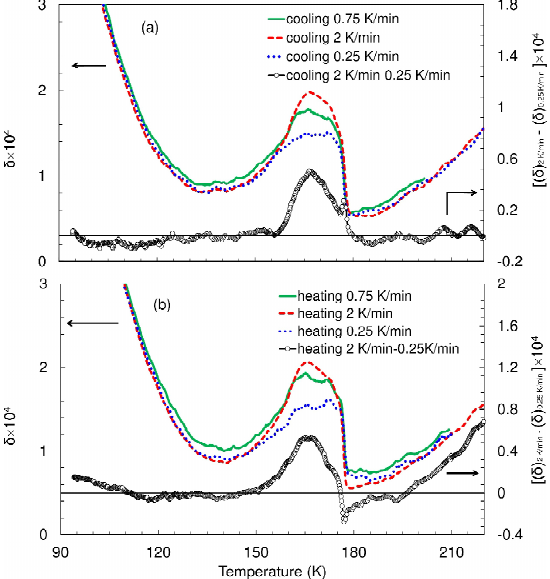
Fig. 2. Internal friction,  , in thermocycles 250K – 95K – 250K performed under cooling-heating rates of 2 K/min, 0.75 K/min, and 0.25 K/min: (a) cooling (b) heating; difference between spectra at 2 K/min and 0.25 K/min is shown as well. Oscillatory strain amplitude  = 10 -5 . 0